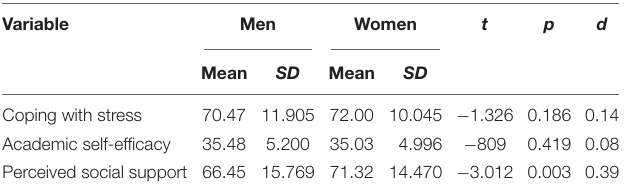
TABLE 2 | Difference between men and women in relation to coping with stress, academic self-efficacy, and perceived social support. Variable